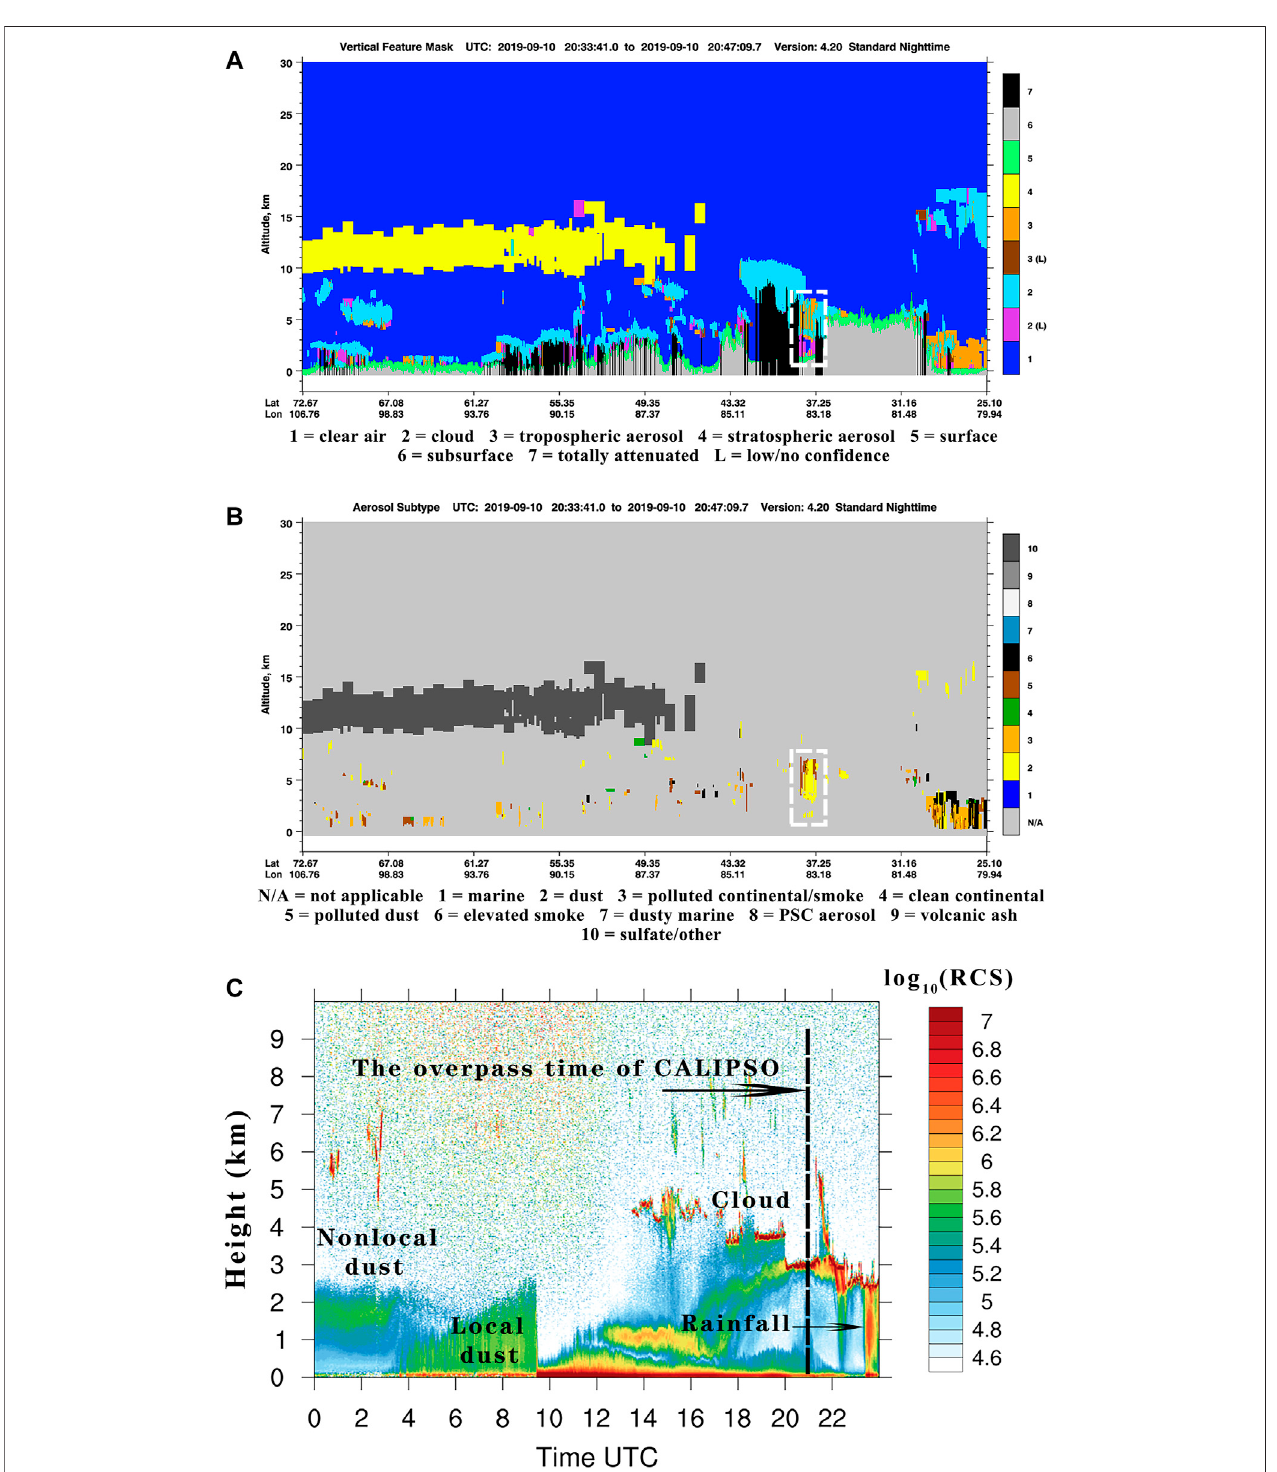
FIGURE 4 | Vertical pro fi les of dust aerosols and cloud layers on September 10, 2019 at Tazhong. (A) Purple and light blue in white dashed rectangle show the cloud layers detected by CALIPSO Vertical Feature Mask products. (B) Yellow inwhitedashed rectangle shows the dust aerosoldetected byCALIPSO. (C) Normalized range-corrected signal in logarithmic scale observed from the ceilometer. The black dashed line denotes the passing time of CALIPSO over Tazhong station. Height is above-the-ground level in kilometers.